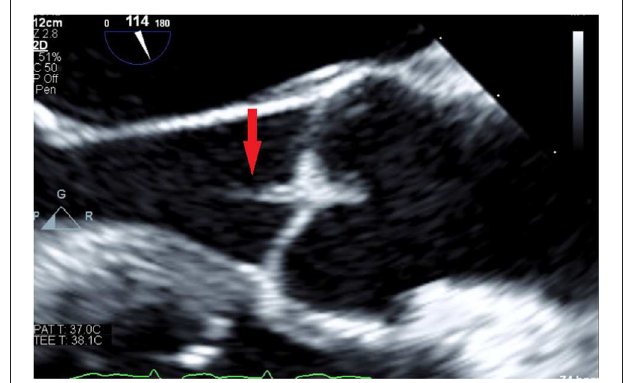
FIGURE 2 | Transesophageal echocardiogram demonstrating small aortic valve vegetation (red